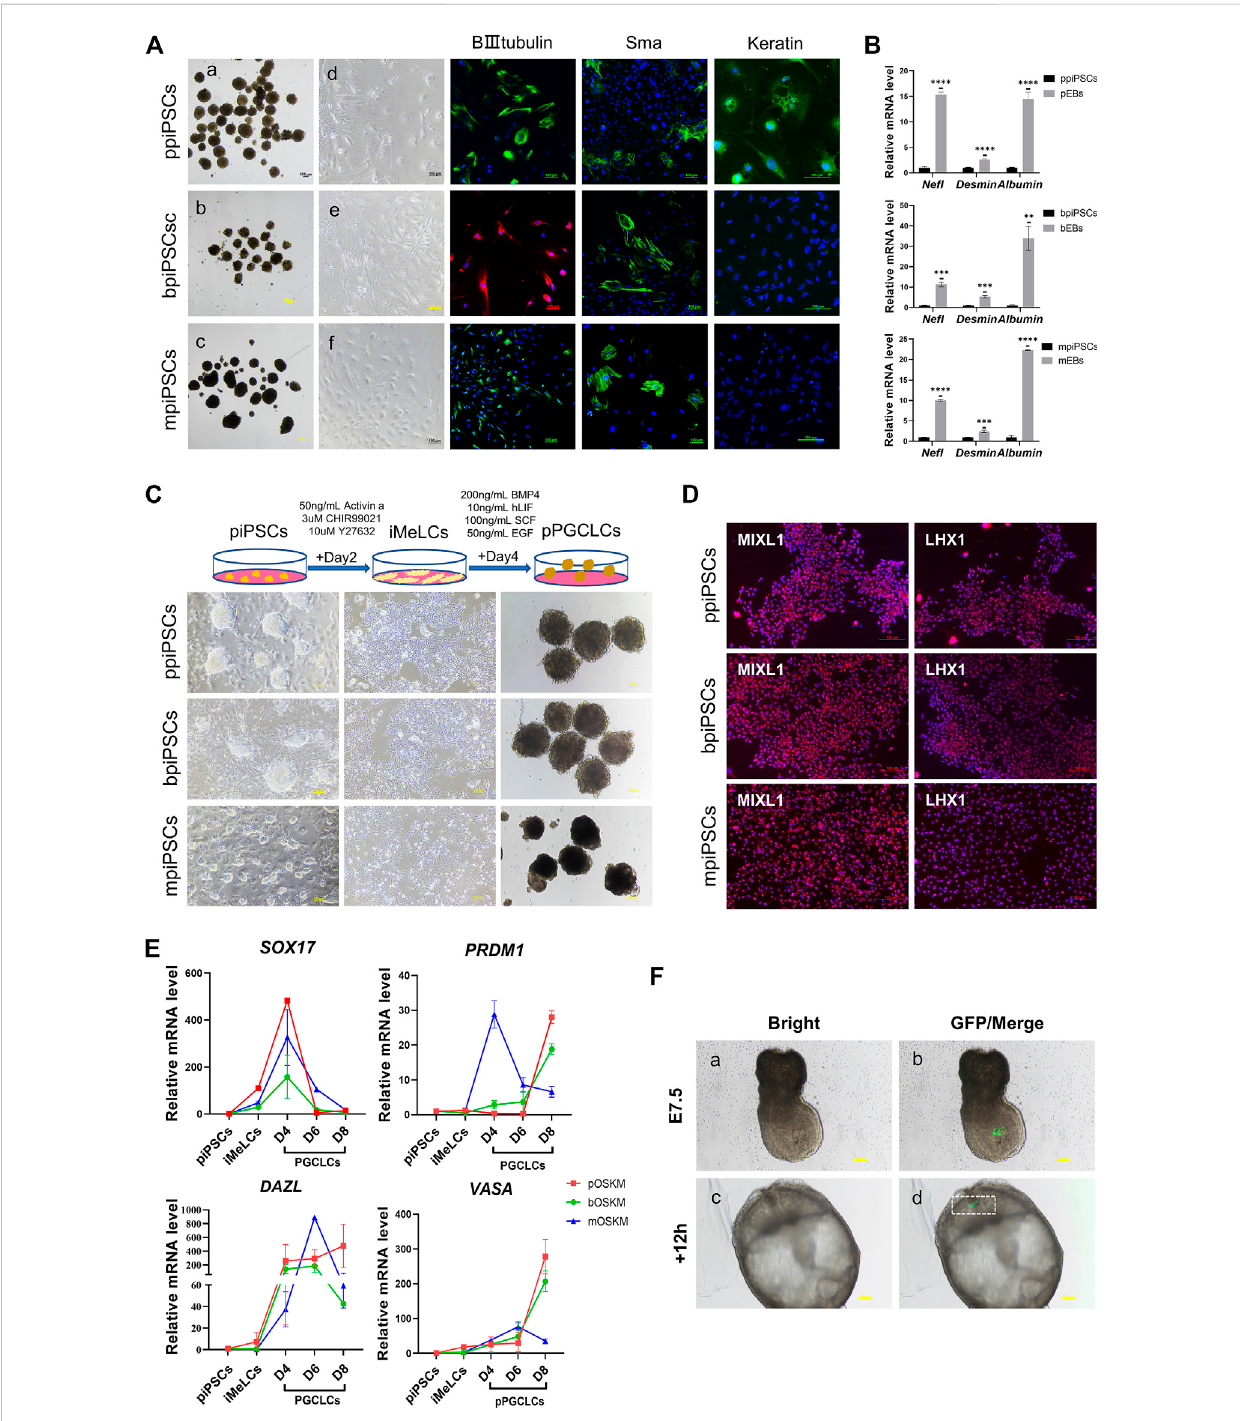
FIGURE 3 Differentiation potency of mpiPSCs, bpiPSCs and ppiPSCs in vitro . (A) a-c. EBs-like spheroids derived from mpiPSCs, bpiPSCs and ppiPSCs; d-f. EB- likespheroidsspreadondishescoatedwithgelatindisplayeddistinctsignsofdifferentiation.Theimmuno fl uorescencestainingofdifferentiationmarkers β III-Tubulin, Sma and Keratin in EBs from piPSCs. Scale bar, 100 µm. (B) qPCR analysis of the expression of differentiation-related genes in EB-like spheroids and piPSCs cells. Data are depicted as mean ± SD. * p < 0.05, ** p < 0.01, *** p < 0.001, **** p < 0.0001, ns, no statistical signi fi cance. (C) Generation of pPGCLCs and their morphology. Scale bar, 100 µm. (D) Immuno fl uorescence analysis of mesodermal markers MIXL1 and LHX1. Scale bar, 100 µm. (E) qPCR analysis of the expression of key genes for PGC speci fi cation and development in piPSCs, iMeLCs and pPGCLCs. Data are depicted as mean ± SD. (F) Analysis of the contribution of ppiPSCs to E7.5 mouse embryos. (a, b) Injection of GFP labeled ppiPSCs-9 to E7.5 mouse embryos. (c, d) Injected E7.5 mouse embryos cultured for 12 h. Scale bar, 100 µm.